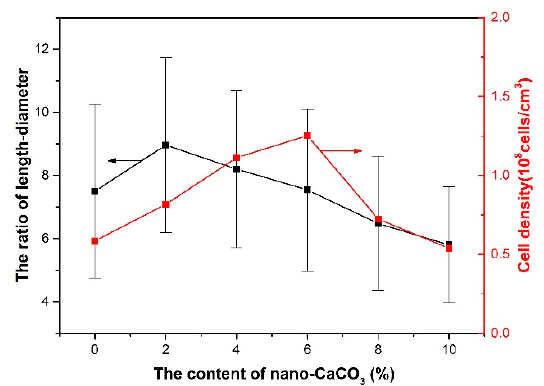
Figure 21. The average ratio of length–diameter and cell density of the transition layer of parallel sections with different content nano-CaCO 3 .